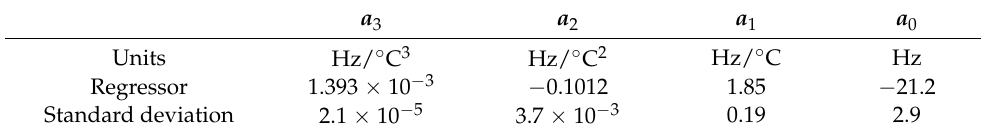
Table 1. Third-order polynomial coefficients from the best calibration data fit.